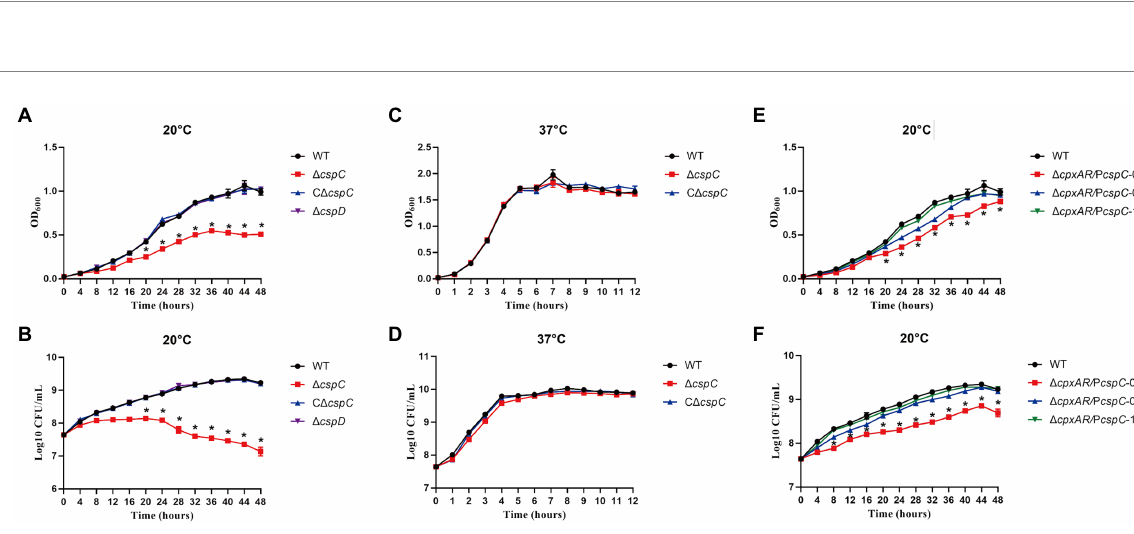
FIGURE 3 CspC is critical for APP cold growth. The growth rates of the WT, ∆ cspC , C ∆ cspC and ∆ cspD strains at 20 ° C were monitored by measurement of OD600 (A) and viable cell counts (B) . The growth rates of the WT, ∆ cspC and C ∆ cspC strains at 37 ° C were monitored by measurement of OD600 (C) and viable cell counts (D) . The growth rates of strains expressing cspC with IPTG at indicated concentrations were monitored by measurement of OD600 (E) and viable cell counts (F) . * p <